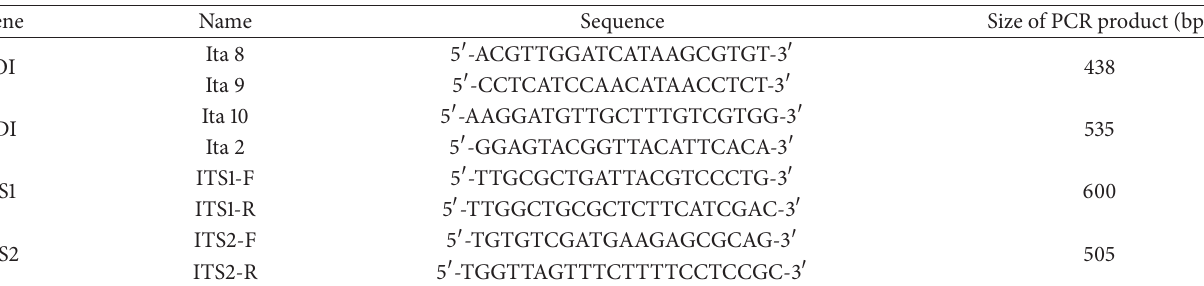
Table 1: The name and sequences of the primers for